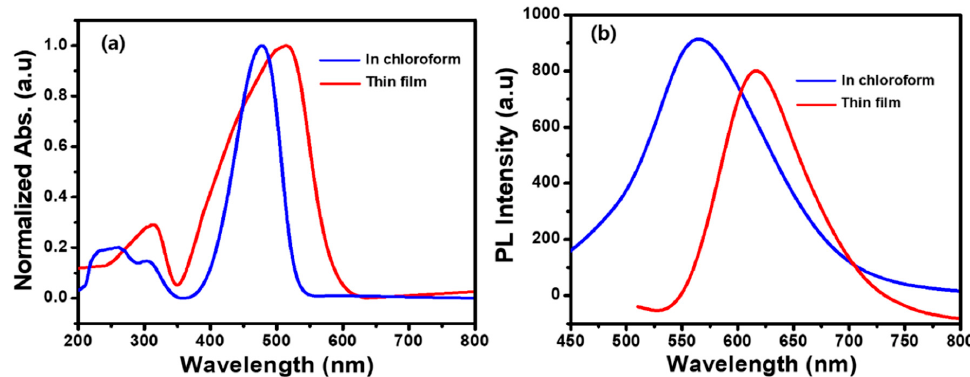
Figure 2. ( a ) UV-Vis absorption and ( b ) photoluminescence (PL) spectra of a DVB-T-ID SOM in a chloroform solvent and solid state thin film. Table 1. Thermal, optical and electrochemical parameters of the synthesized DVB-T-ID OSM.